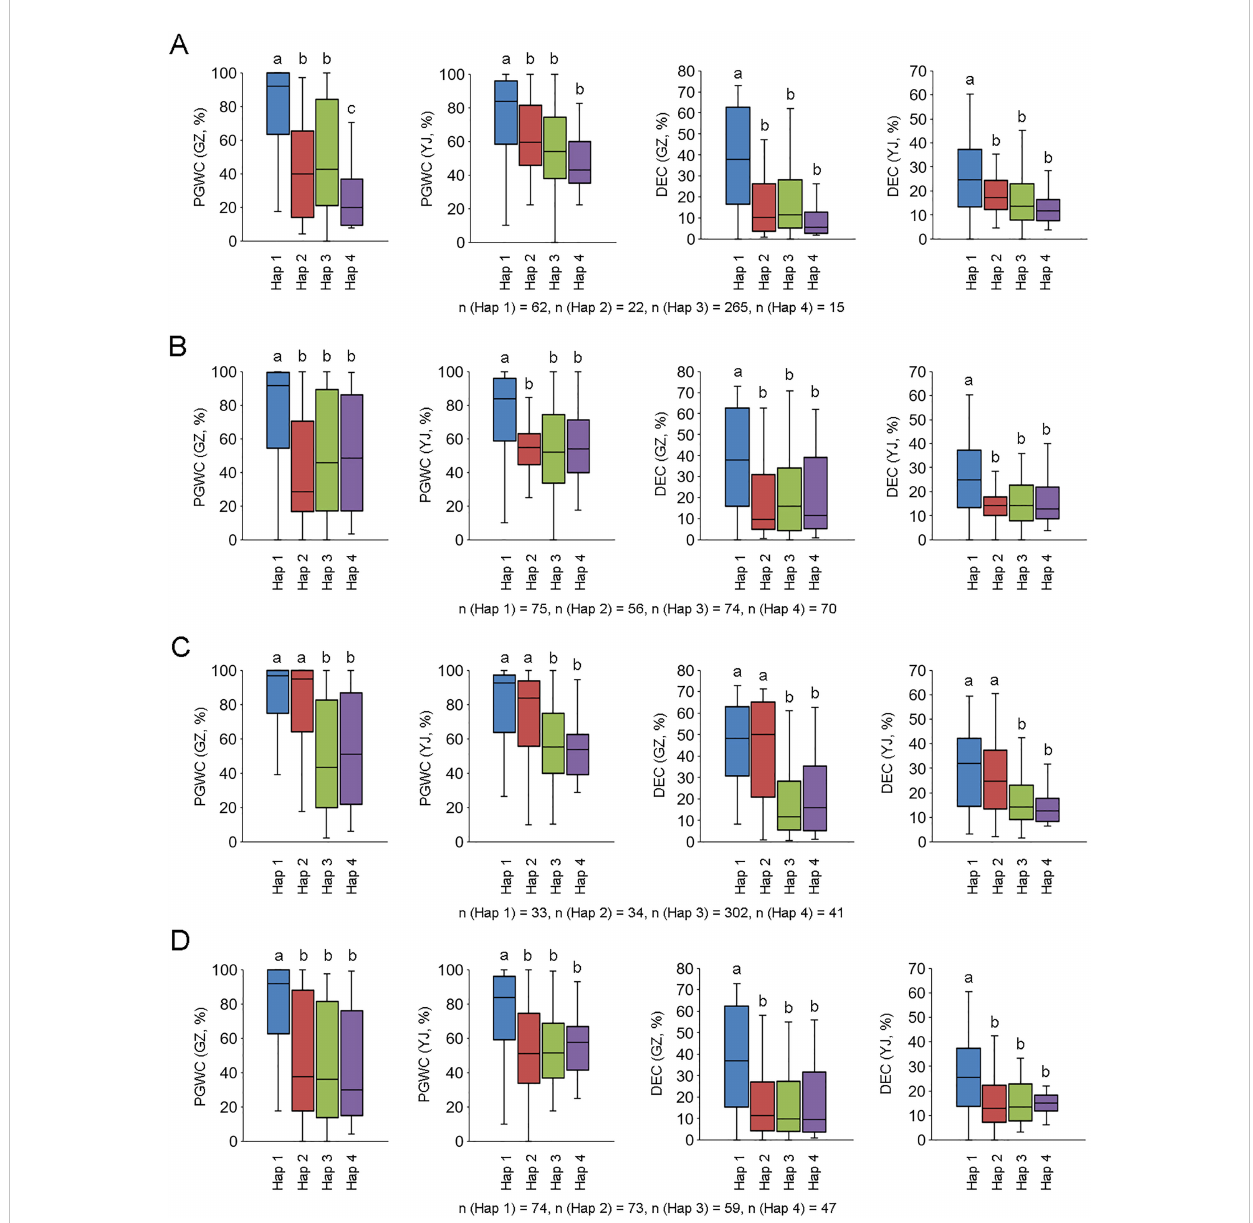
FIGURE 5 Phenotype comparisons among different haplotypes of four candidate genes. (A – D) are LOC_Os10g36170 , LOC_Os10g36260 , LOC_Os10g36340 and LOC_Os10g36610 , respectively. Different letters indicate signi fi cant difference at P <